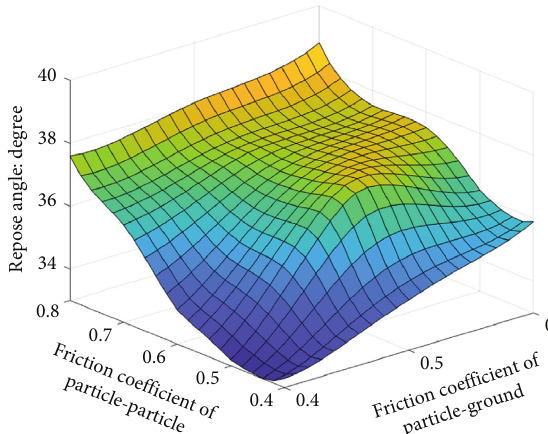
Figure 9: Effect of f p-p and f p-g on the angle of repose.